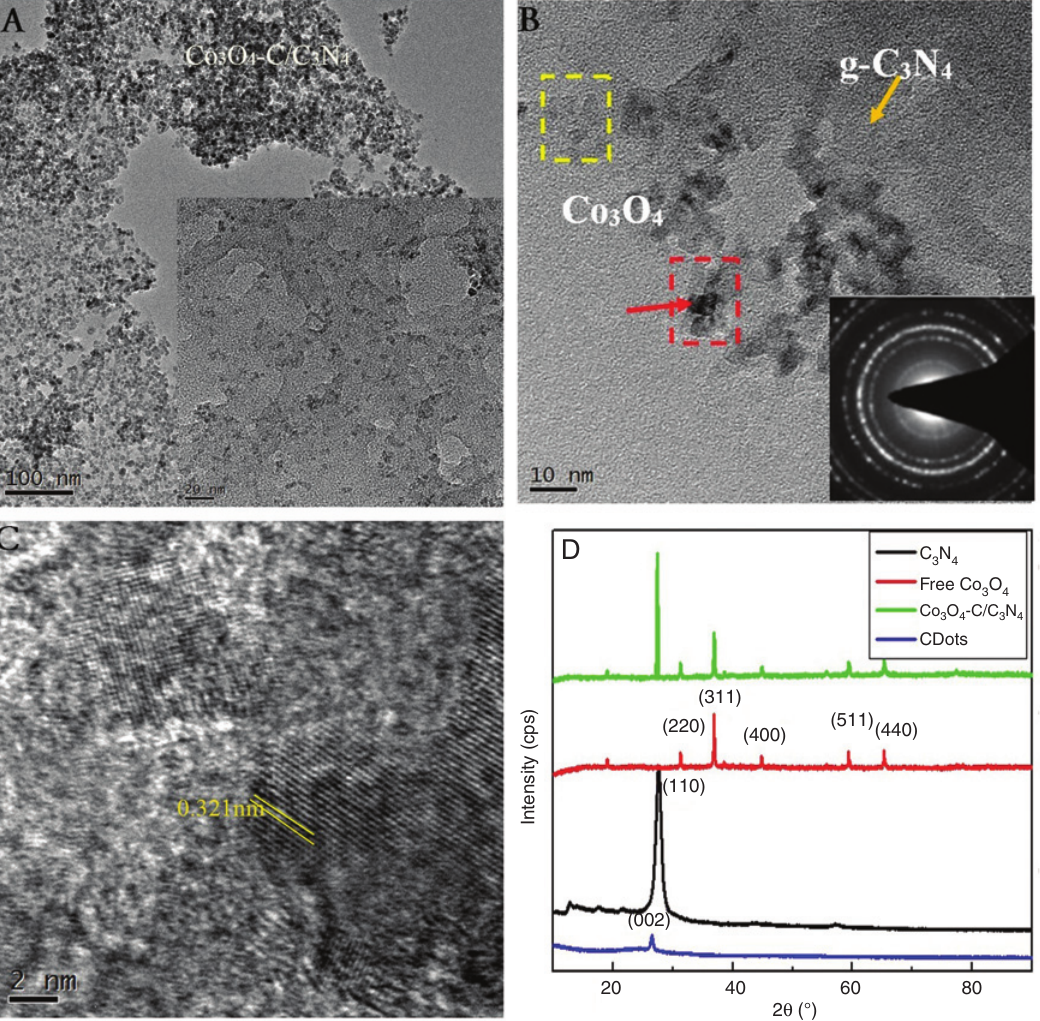
Figure 2: (A–C) Transmission electron microscopy (TEM) images and (D) X-ray diffraction (XRD) analysis of the carbon nanodots (CDots), free Co O , C N and synthesized Co 3 4 3 4 inset in (B) is the diffraction rings of Co crystalline CDots marked in the blue dash rectangle in